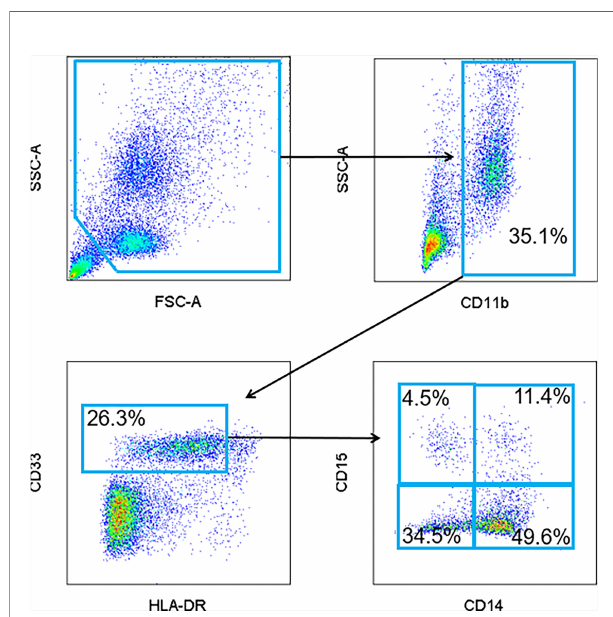
FIGURE 1 | Representative fl ow cytometry gating strategy for MDSC. Peripheral blood mononuclear cells (PBMC) were isolated from patient peripheral blood samples. Circulating levels of total MDSC (CD11b + , CD33 + , and HLA-DR lo/- ), granulocytic (CD15 + ), monocytic (CD14 + ) and early (CD14 - / CD15 - ) MDSC were quanti fi ed and visualized by fl ow cytometry. A population of CD14+/CD15+ double positive cells was also identi fi